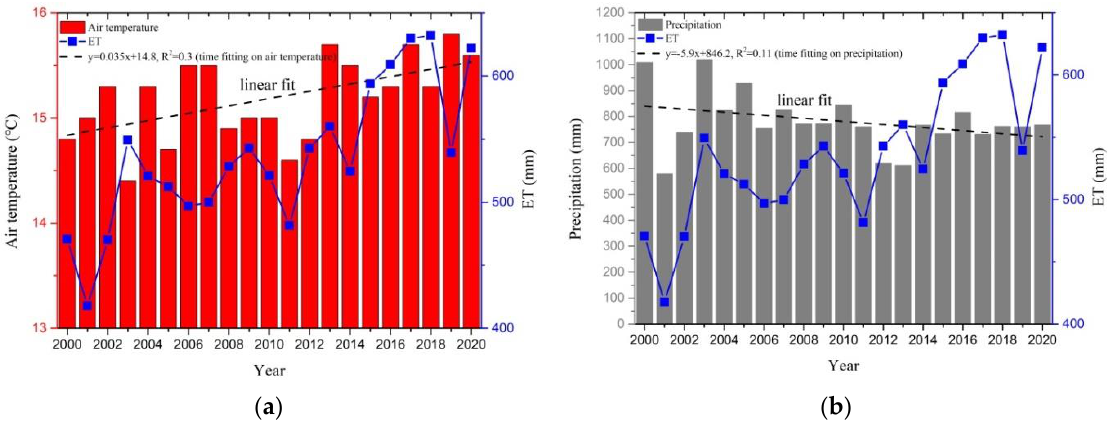
Figure 6. Annual air temperature ( a ) and precipitation ( b ) variations from 2000 to 2020. The spatial distribution of multi-year average ET in Henan province from 2000 to 2020 is shown in Figure 7. The annual average ET had obvious spatial distribution characteristics, with high values in the west and southeast and low values in the north. To a certain extent, the spatial distribution of ET had close relation to the uneven distribution of vegetation in Henan province. Areas with low ET values (about 0–400 mm/a) always appeared in the north where the vegetation coverage was relatively low (as is shown in Figure 8). In addition, the vegetation coverage of the provincial capital, Zhengzhou, was decreasing year by year due to rapid economic development and more frequent human activities, and hence, ET values in Zhengzhou were relatively low. Areas with high ET values (above 600–700 mm/a) were mostly concentrated in the west and southeast where there were mountain and field areas, and the vegetation coverage in these areas can reach 0.8. The spatial distribution of the ET trend in Henan province from 2000 to 2020 is shown in Figure 9. According to the ET trend slope of regression equation (10), the trend of ET was divided into three categories: significantly decreasing trend ( − 21 < ET trend ≤ 0), no obvious change (0 < ET trend ≤ 4 and 4 < ET trend ≤ 8), and slightly increasing trend (8 < ET trend). Among them, the areas with an increasing ET trend were mainly distributed in the west and southeast which belonged to the mountain forest and farmland areas with high vegetation coverage. However, the increasing trend was not obvious. The decreasing trend areas showed a “scattered distribution,” and by combining them with the land-use map, we can find that the main reason for the decrease was the population density and urbanization effects. The ET trend in most areas had no obvious changes, and therefore the inter-annual ET changes were relatively stable. In general, the average inter-annual change rate of ET in Henan province over the past 21 years was 3.4 mm/a, and the overall trend was increasing.